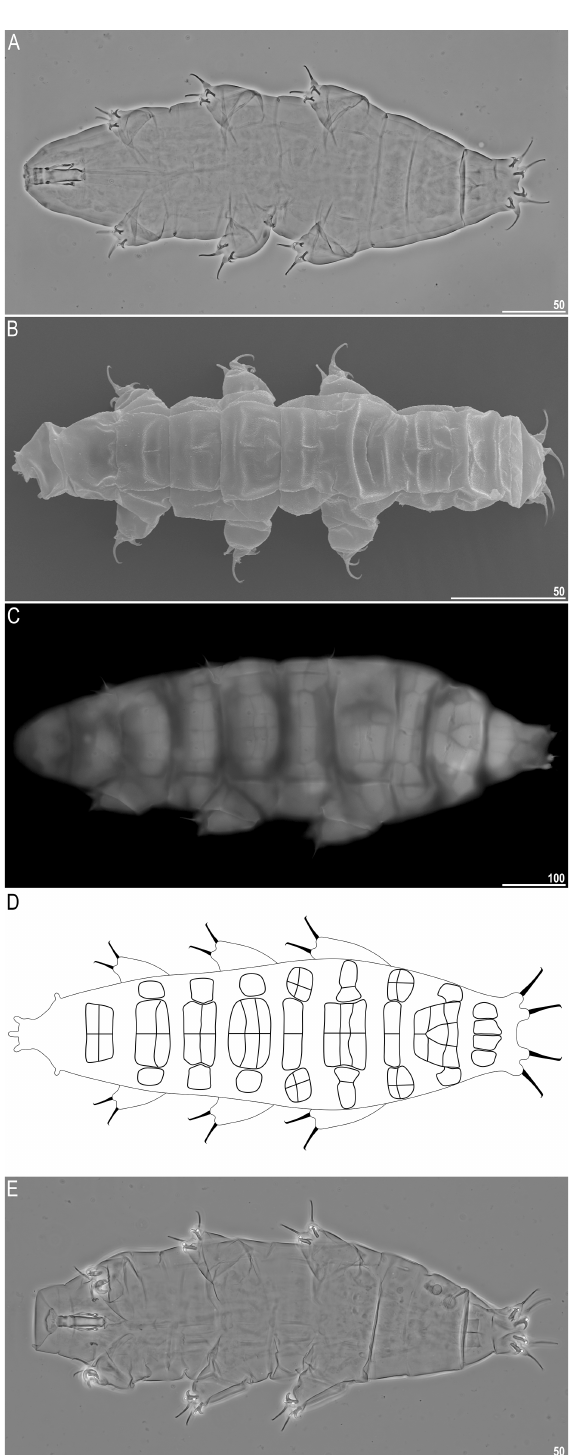
Figure 1. General morphology of Milnesium decorum sp. nov. ( A ) juvenile habitus, PCM (holotype, juvenile); ( B ) hatchling habitus, SEM (paratype); ( C ) adult habitus with visible pseudoplates; UVM (paratype, simplex); ( D ) pseudoplate arrangement based on the observation of holotype and paratypes in PCM, UVM and SEM (created with MS PowerPoint 2016); ( E ) mature male habitus, PCM (paratype). All scale bars in